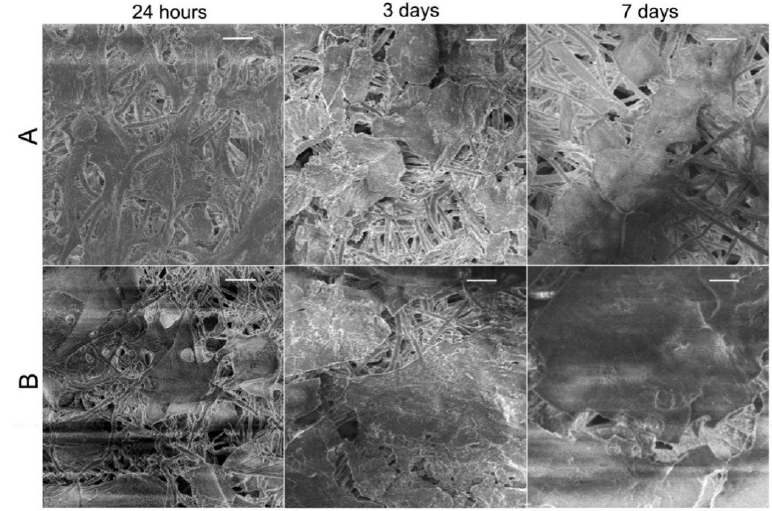
Figure 9. SEM of chondrocyte proliferation on ( A ) non-porous PDLLA fibrous membrane; ( B ) PDLLA/nHA composite fibrous membrane. Scale bars represent 10 μm.